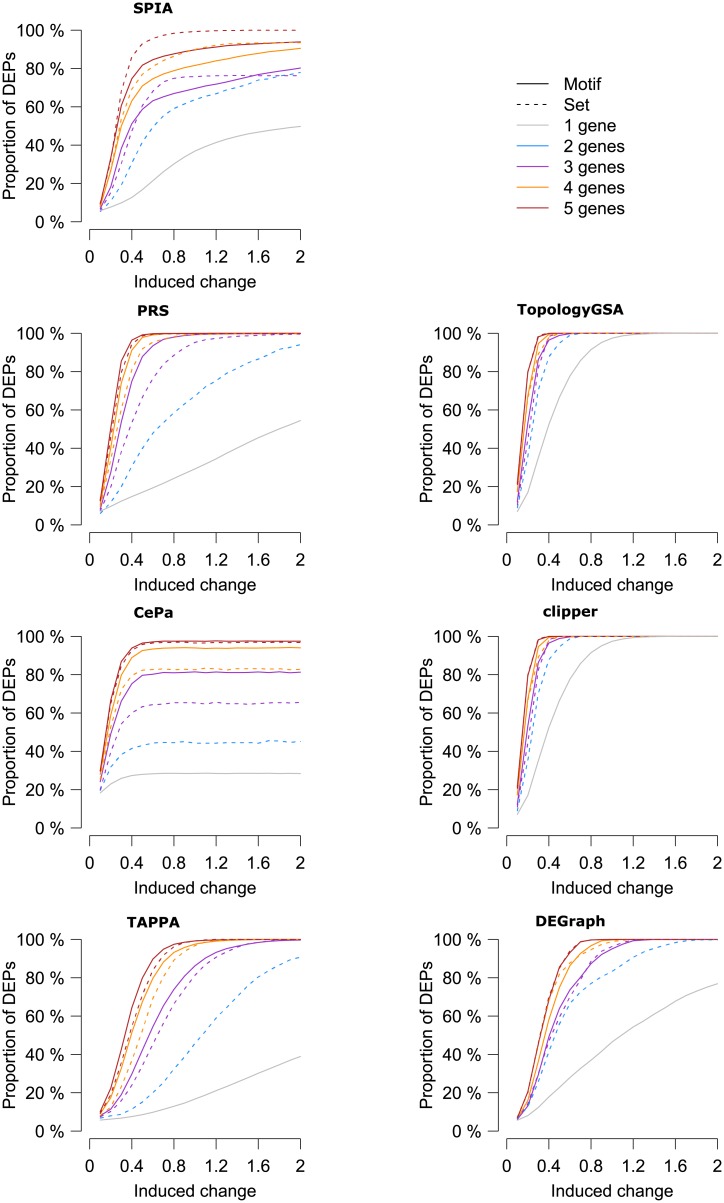
Comparison of the effect of expression change in a single gene, multiple genes and topological motifs.Combined influence of single gene, multiple genes and topological motifs on the proportion of differentially expressed pathways (DEPs) at varying induced expression changes is displayed. Sets of multiple genes and topological motifs are shown in the dashed and solid lines of the same color, respectively.